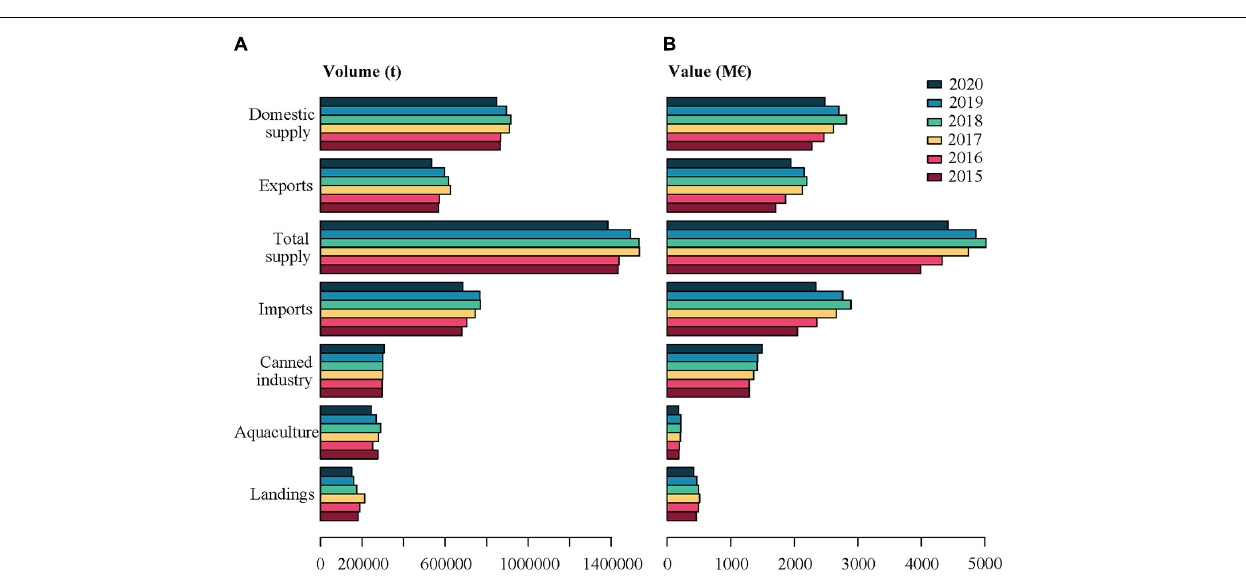
FIGURE 4 | Impacts of COVID-19 on the Galician seafood sector in (A) volume (t) and (B) value